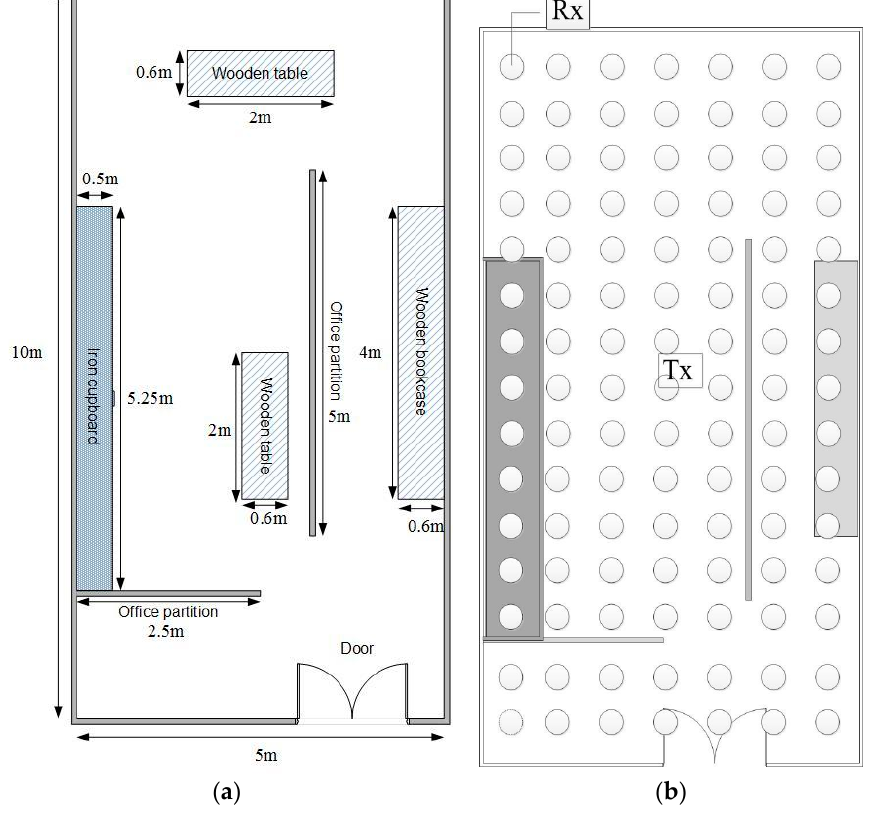
Figure 2. ( a ) The simulated environment (top view); ( b ) The location of transmitting and receiving points in the simulated environment.